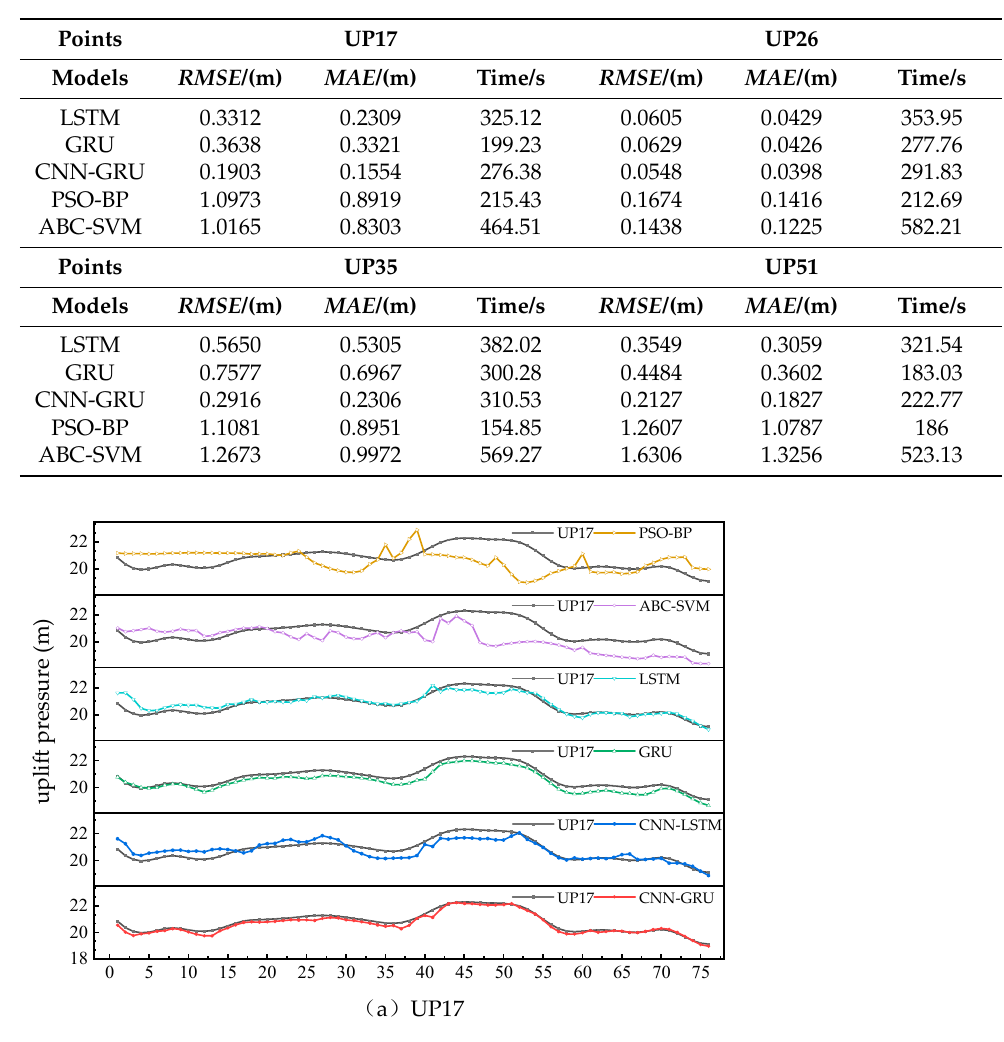
Table 6. The value of each evaluation index.